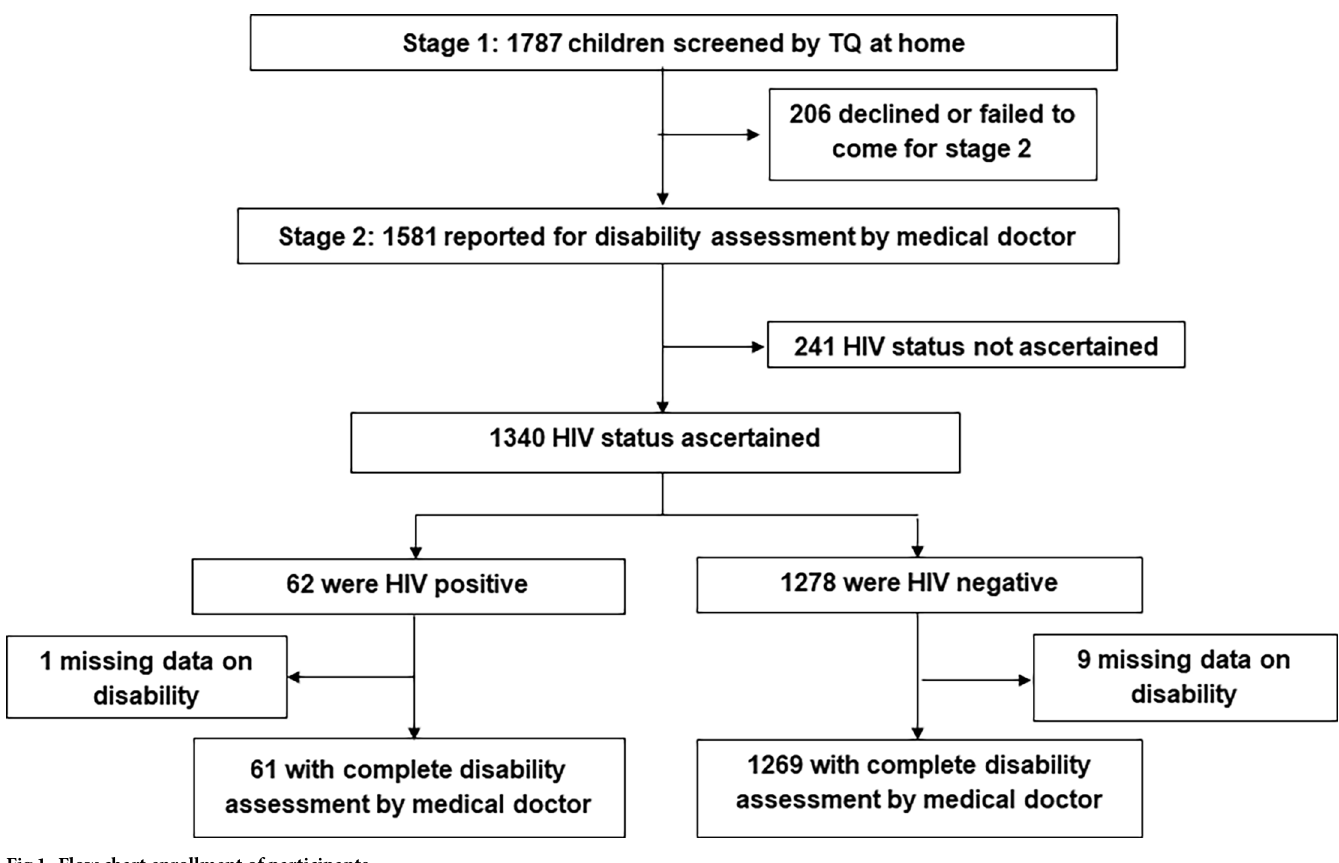
Fig 1. Flow chart enrollment of participants.